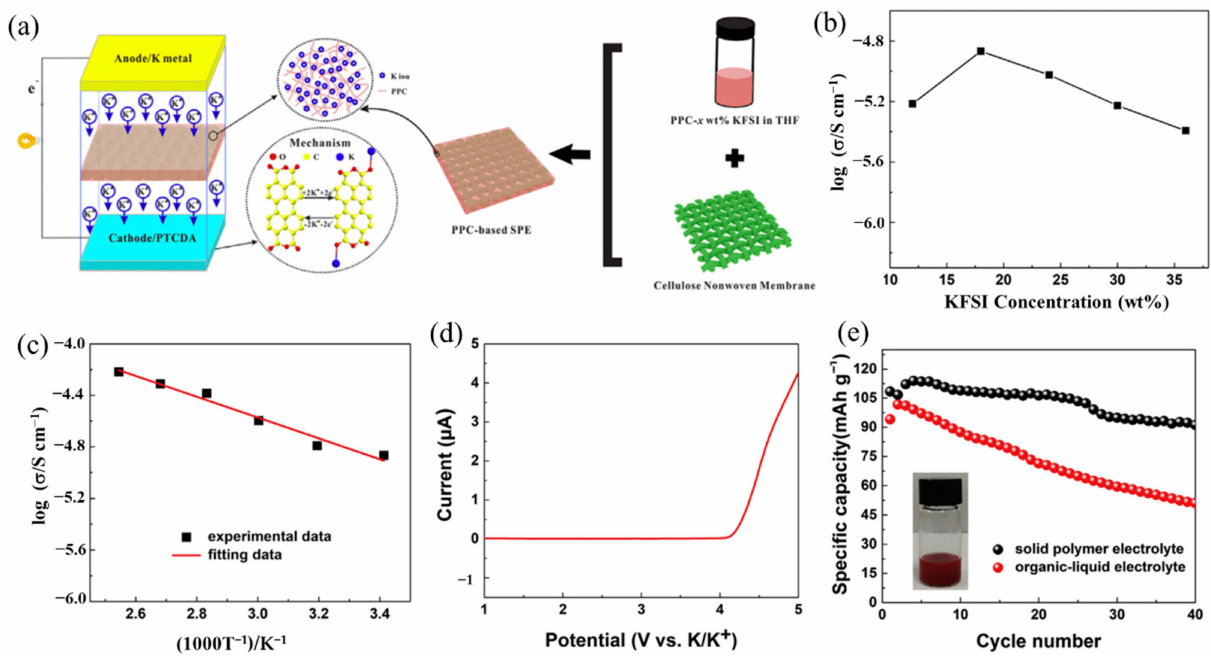
Figure 10. ( a ) The design of PPC-based solid polymer electrolyte with cellulose nonwoven backbone (PPCB-SPE) for high-safety solid-state KIBs. ( b ) Ionic conductivity of the SPE with varied concentra- tion of KFSI in PPC. ( c ) Ionic conductivity of the SPE at different temperature with a concentration of PPCB-SPE-18 wt% KFSI. ( d ) The linear-sweep voltammetry results for the SPE. ( e ) Cycling perfor- mance of the assembled full cell with PPCB-SPE or organic–liquid electrolyte at a current density